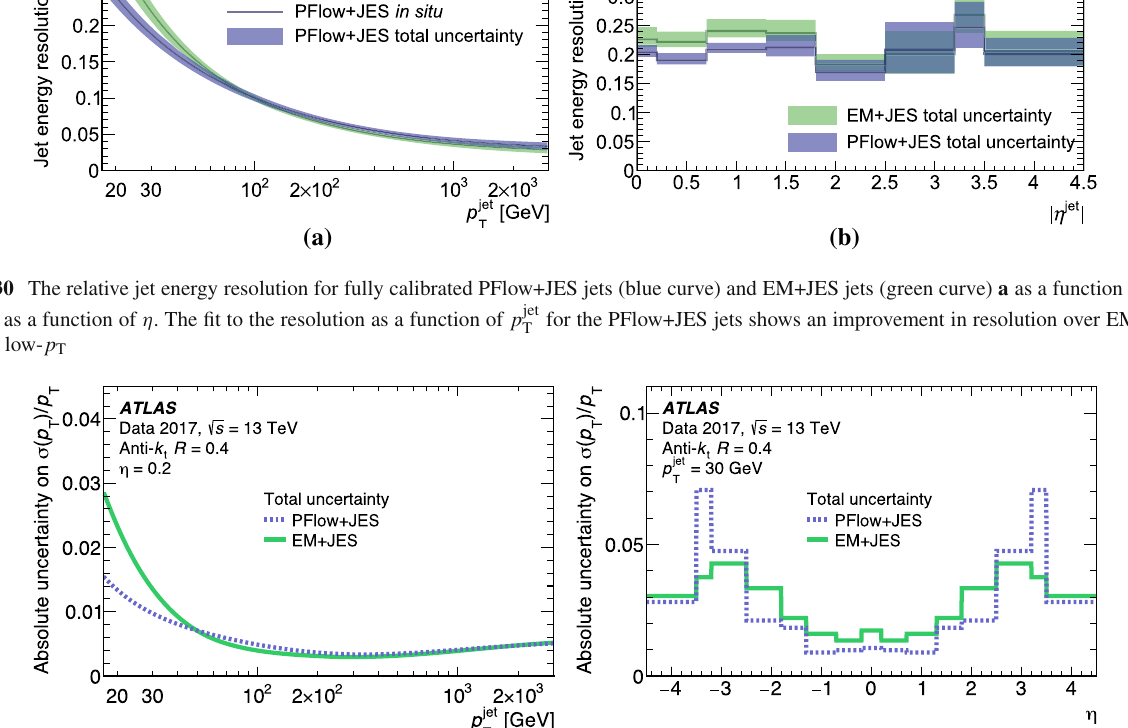
Fig. 31 Fractional jet energy resolution systematic uncertainty summed across all components for anti- k t R = 0 . 4 jets a as a function of jet p T at η = 0 . 2 and b as a function of η at p = 30 GeV. The total JER uncertainty is shown for both EM+JES and PFlow+JES T